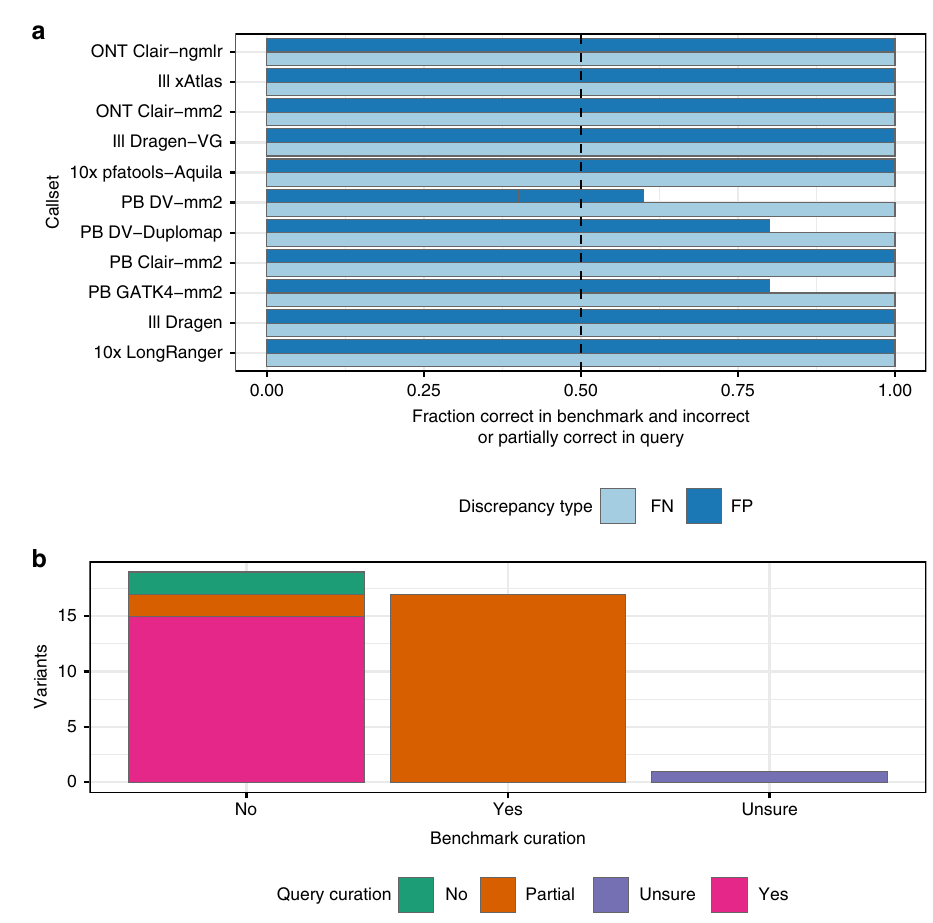
Fig. 3 Evaluation of benchmark ’ s ability to reliably identify FNs and FPs across technologies. a Proportion of 10 randomly selected FPs and 10 randomly selected FNs from 11 callsets from Illumina (Ill), 10x Genomics (10x), PacBio HiFi (PB), and Oxford Nanopore (ONT) that were determined to be fully correct in the benchmark and incorrect or only partially correct in the query callset. b Breakdown of variants potentially incorrect in the benchmark or correct in the query, where curation of the benchmark determined it to be incorrect (no), correct (yes), or unclear